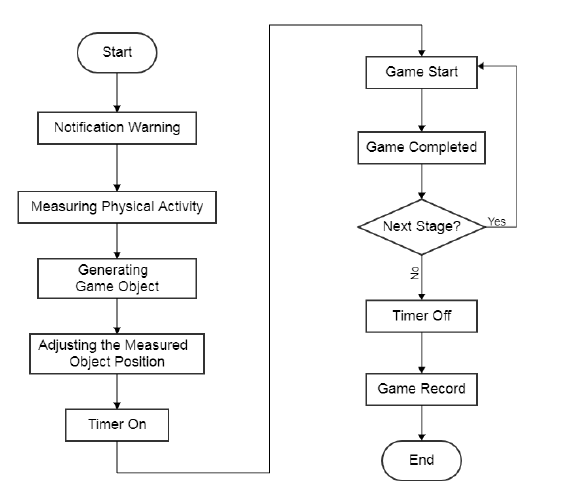
Figure 5. System